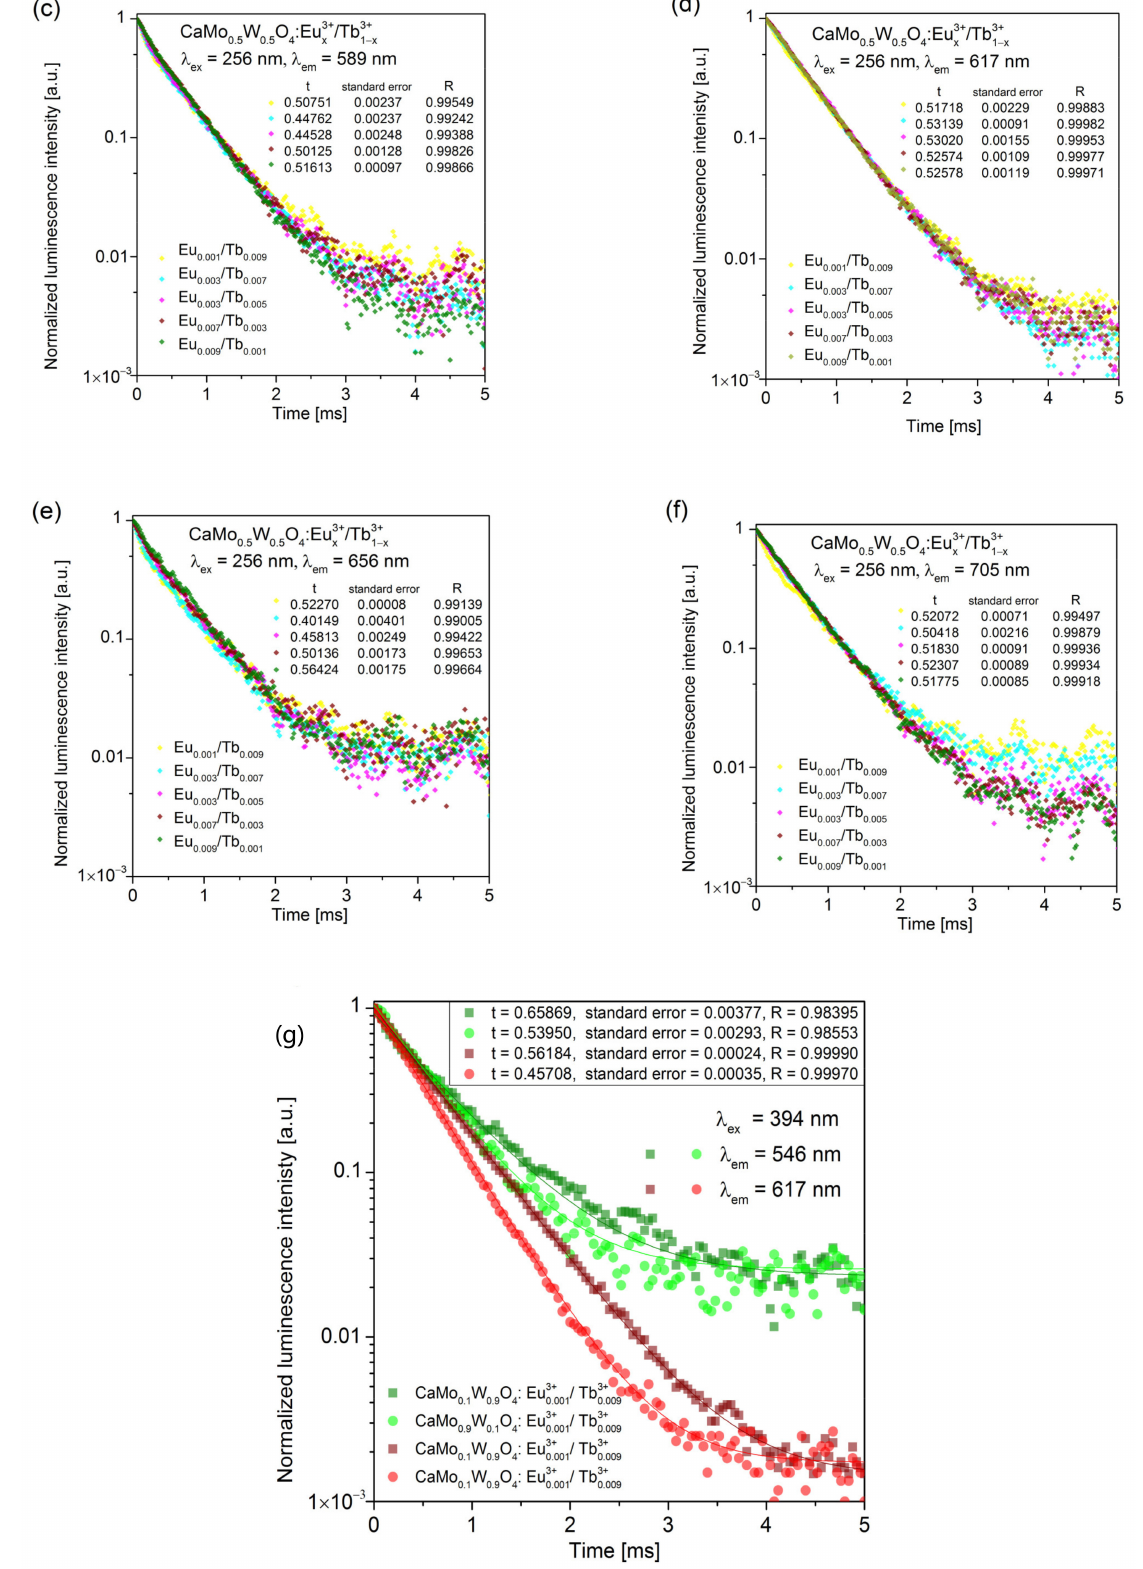
Figure 6. Luminescence decay curves for CaMo y W 1 − y O 4 :Eu 3+ x /Tb 3+ 1 − x ( a ) λ ex = 256 nm, λ em = 490 nm, ( b ) λ ex = 256 nm, λ em = 546 nm, ( c ) λ ex = 256 nm, λ em = 589 nm, ( d ) λ ex = 256 nm, λ em = 617 nm, ( e ) λ ex = 256 nm, λ em = 656 nm, ( f ) λ ex = 256 nm, λ em = 705 nm, ( g ) λ ex = 394 nm, λ em = 546 nm, λ em = 617